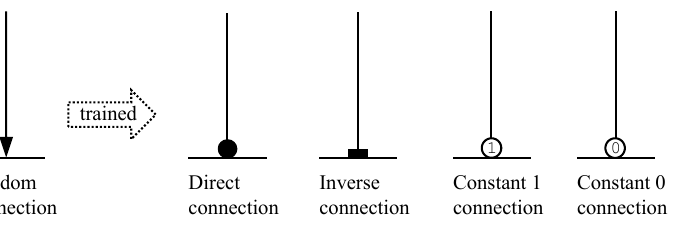
Figure 3. A synaptic connection lands on one state of the four connection states after training.